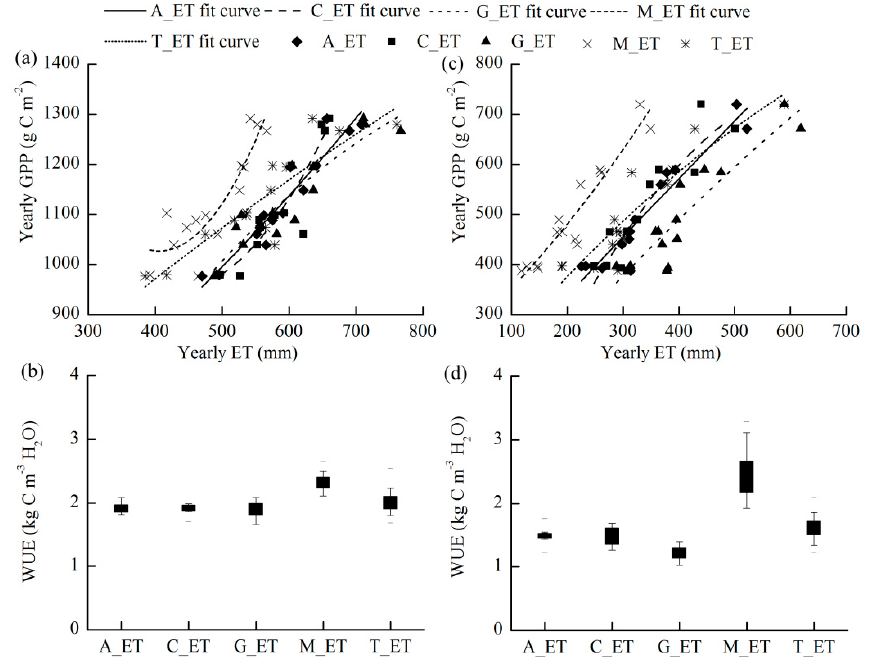
Figure 8. The relationships between yearly GPP and ET and the water-use efficiency of forest and grassland: ( a , b ) forest, and ( c , d ) grassland.